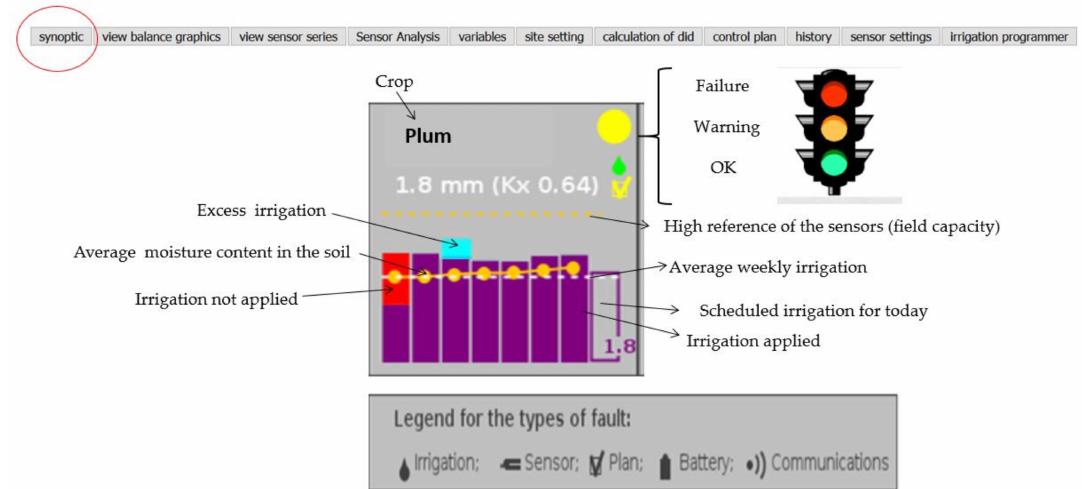
Figure 2. Screenshot of the “synoptic” tab of IRRIX in the year